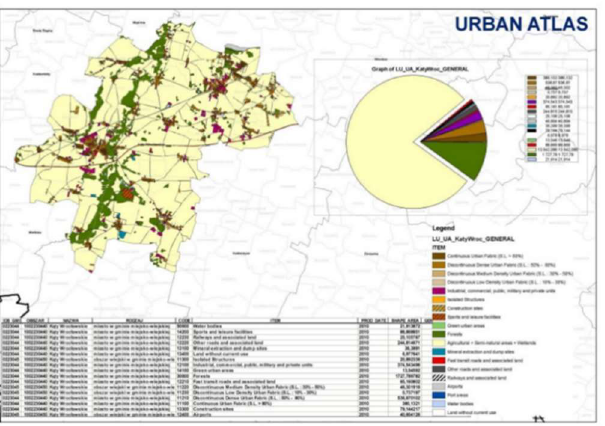
Figure 10. Area of residential areas AU = 964 ha (5.5% of the municipality area). Resources: P. Malczewski, Institute of Territorial Development in Wroclaw.